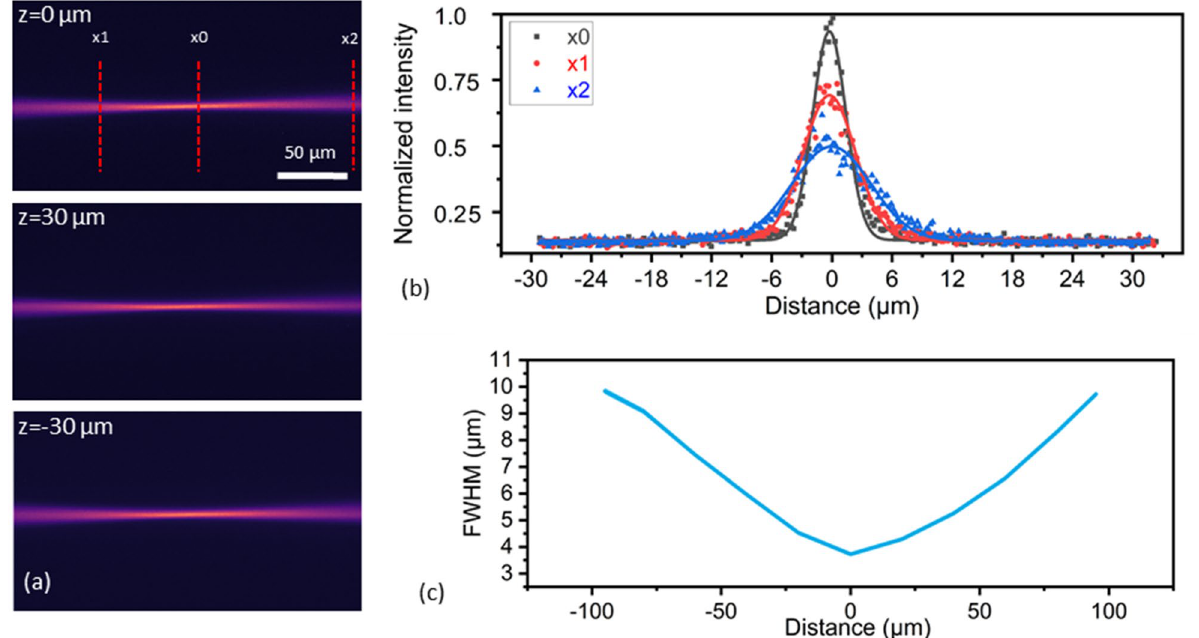
Figure 3. Excitation beam path characterisation. ( a ) Propagation through a fluorescein cuvette at z = 0 μm (unactuated), z = 30 μm (maximum negative actuation) and x = − 30 μm (maximum positive actuation). ( b ) Normalized intensity cross-sections are presented along the length of the beam for three different positions × 1 = − 50 μm, × 0 = 0 μm, × 2 = 95 μm. ( c ) Beam width propagation through the x-axis with beam waist of 3.8 μm